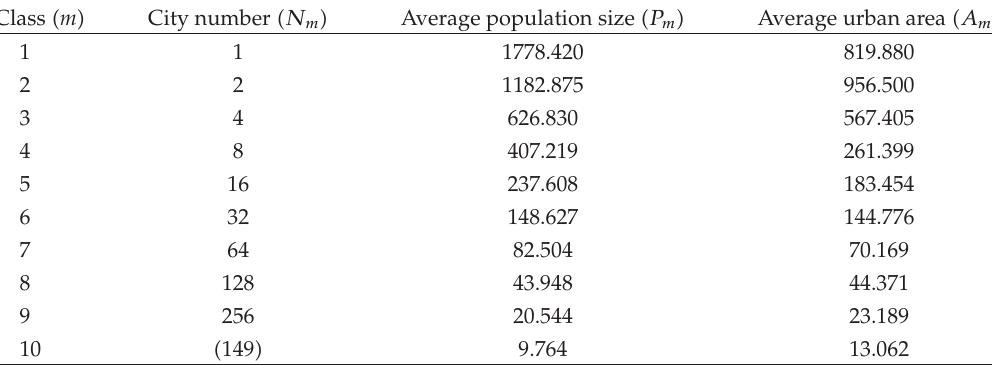
Table 4: The hierarchy of the 660 cities in PRC and the related measures (cid:6) 2005 (cid:7) . Class (cid:6) m (cid:7) City number (cid:6) N m